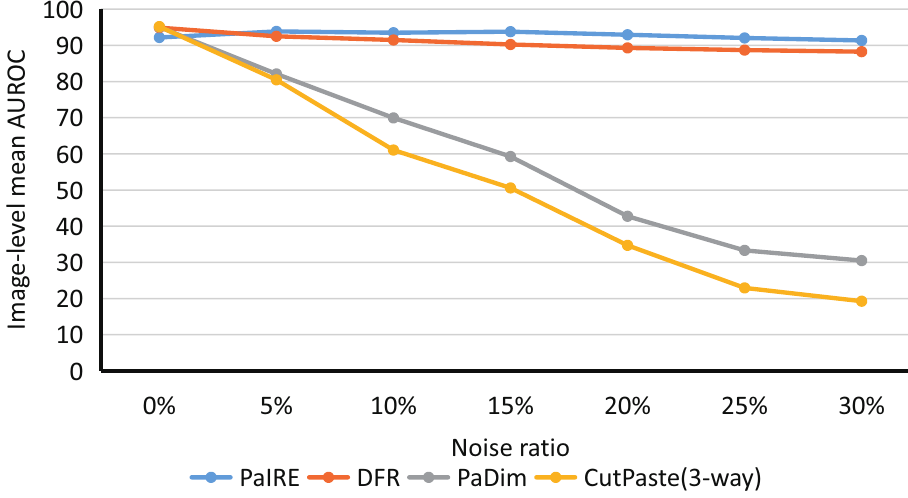
Figure 9. Comparison on MVTec dataset. Table 2. Comparison with SOTA methods at different noise